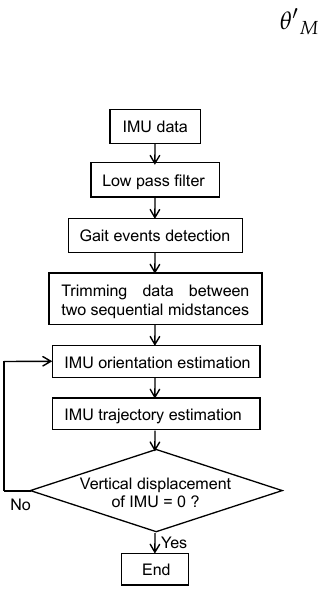
Figure 4. Flow chart of the data postprocessing steps for the estimation of foot trajectory from foot-mounted IMU.